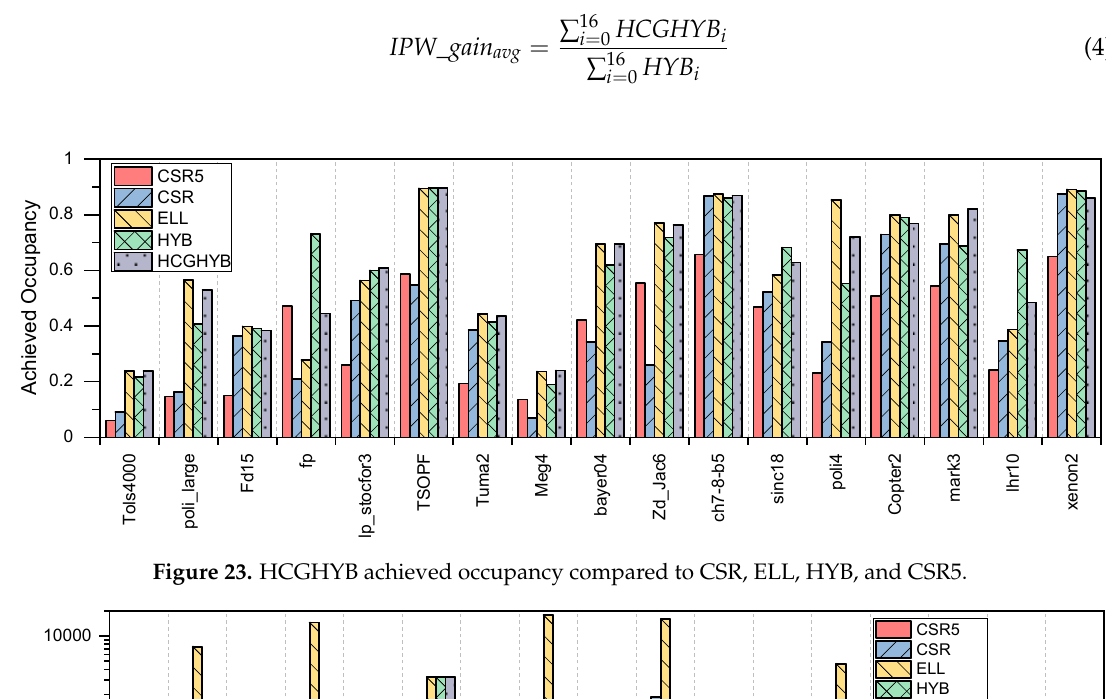
Figure 23. HCGHYB achieved occupancy compared to CSR, ELL, HYB, and CSR5.